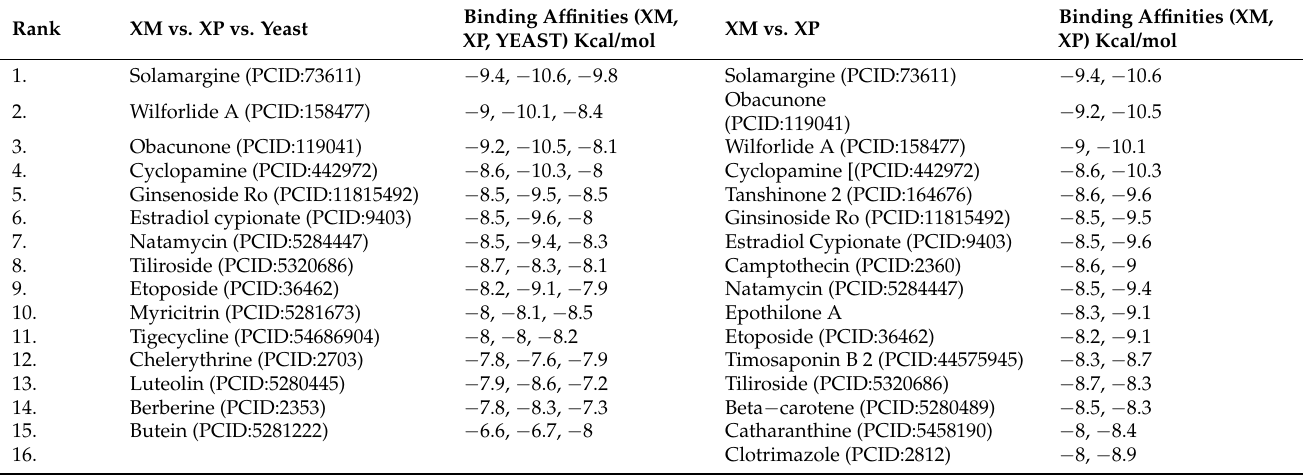
Table 1. Comparative analysis of binding affinities of ligands against XM, XP, & Yeast proteins. Rank XM vs. XP vs. Yeast